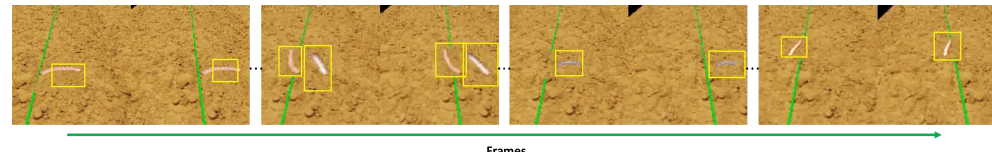
Figure 13. Results of the Faster-RCNN insect detector showing the detected insect pest during the cosimulation of the proposed recognition mechanism with robot in CoppeliaSim and MAT-